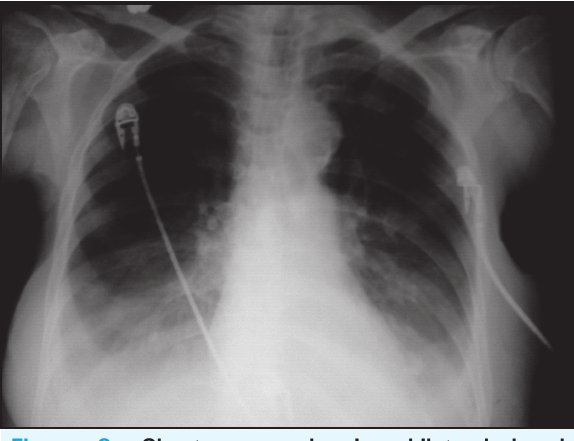
Figure 2. chest x-ray showing bilateral basal consolidation